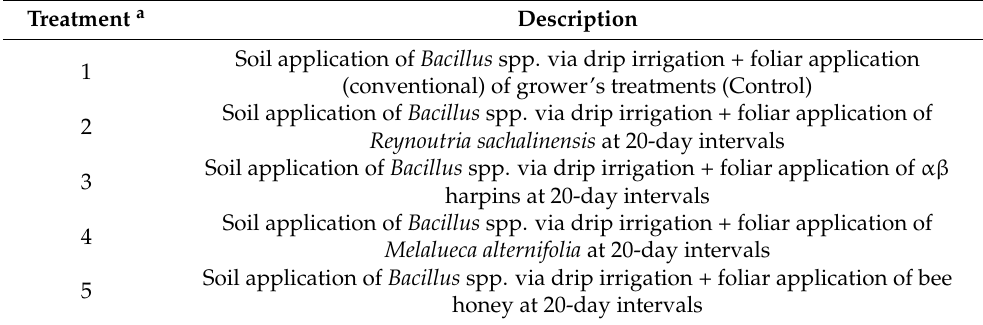
Table 4. Description of the treatment combinations tested in this study for control of major tomato diseases in greenhouse production in 2016 and